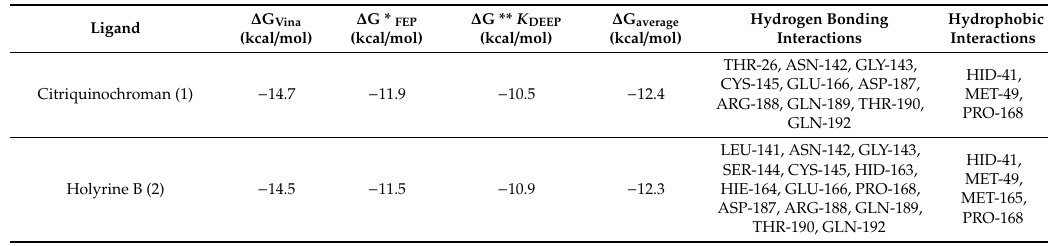
Table 1. M pro top-scoring ligands alongside their binding energies using di ff erent calculation methods and their molecular interactions inside the active